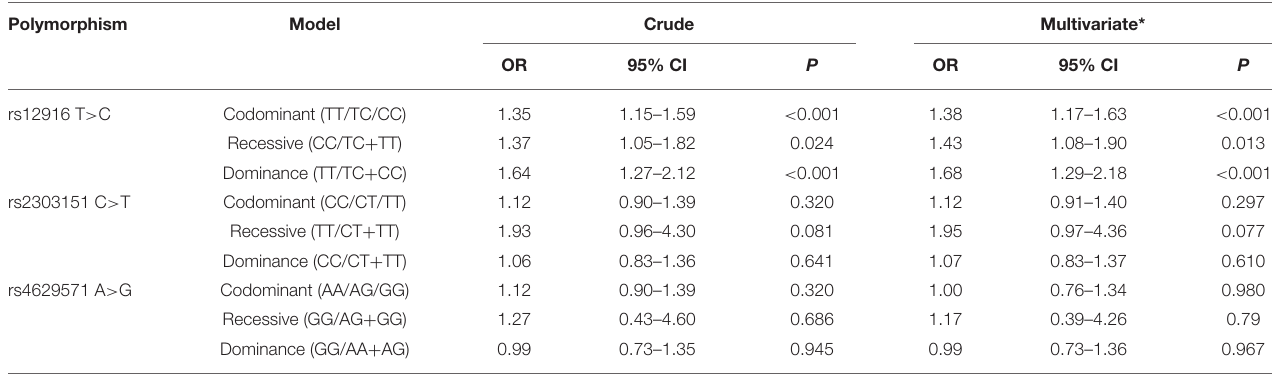
TABLE 4 | Univariate and multivariate adjusted logistic regression analysis of HMGCR gene SNPs and the risk of PTVD. Polymorphism Model Crude Multivariate*